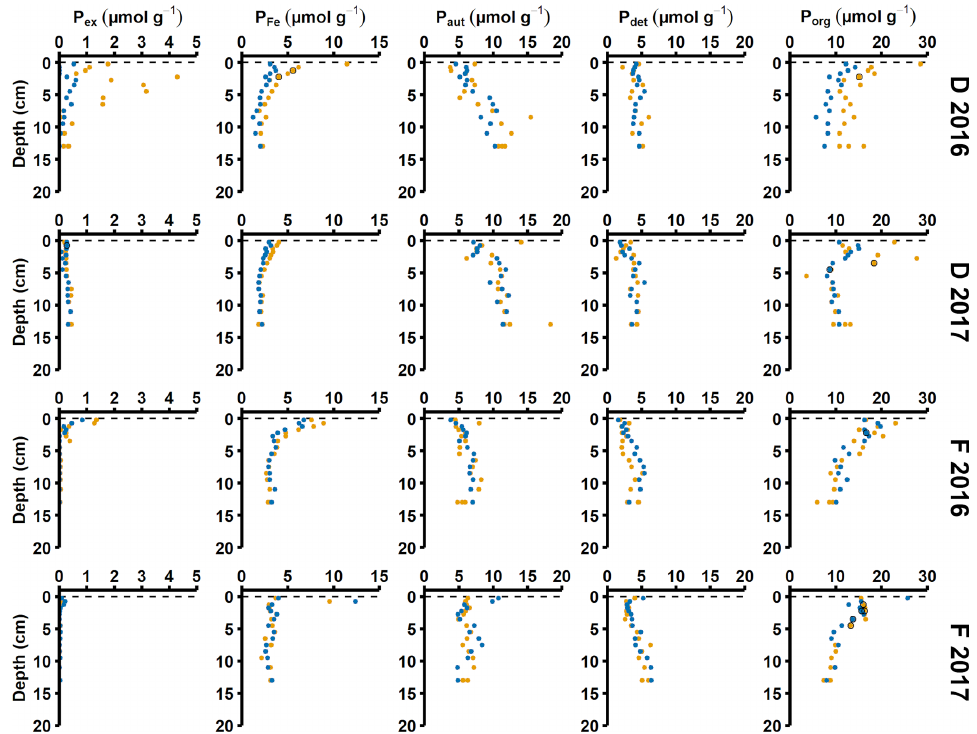
Figure A4. Solid-phase phosphorus speciation. P ex stands for exchangeable or loosely sorbed P, P Fe stands for easily reduced or reactive iron-bound P, P aut stands for authigenic P, P det stands for detrital P, and P org stands for P associated with organic matter. The blue and orange markers represent replicate small sediment cores (inner diameter